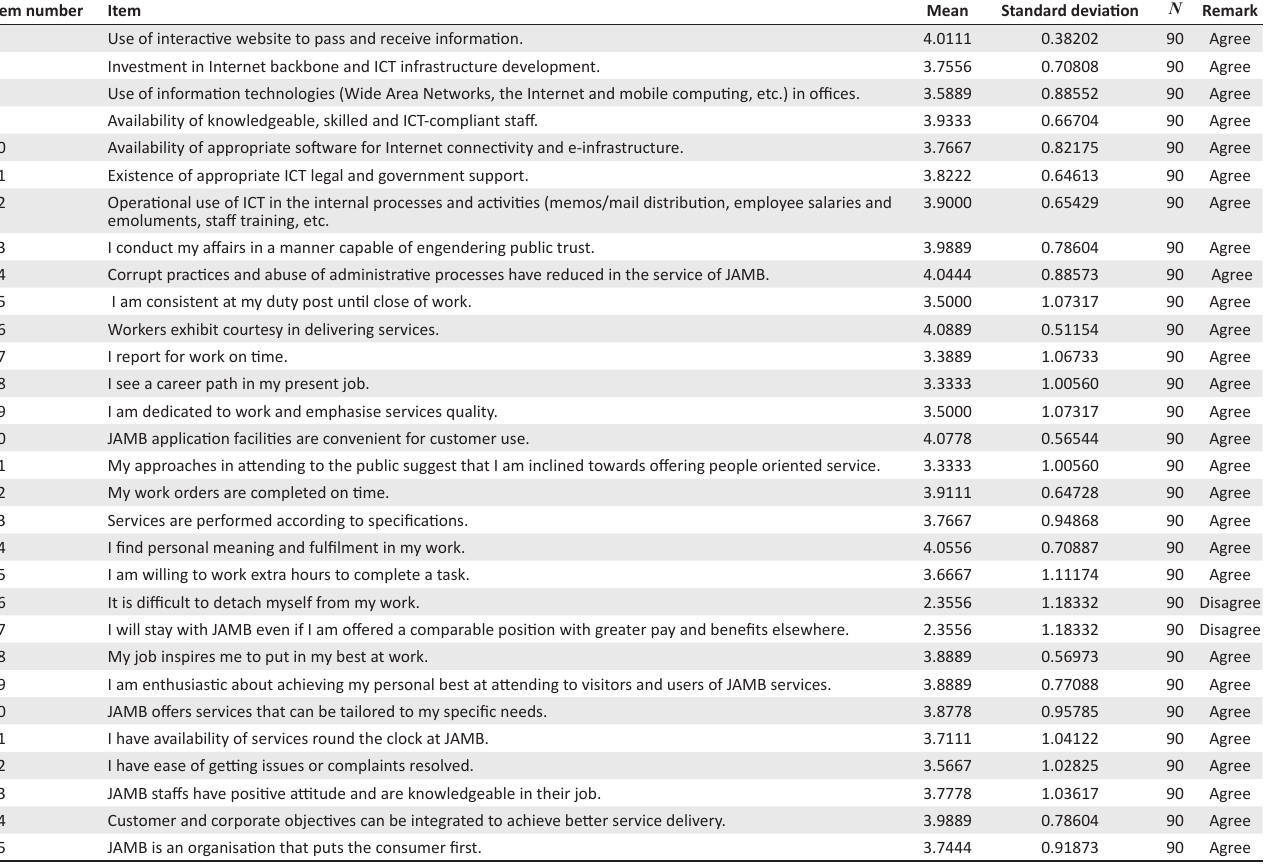
TABLE 1: Standard deviation statistical